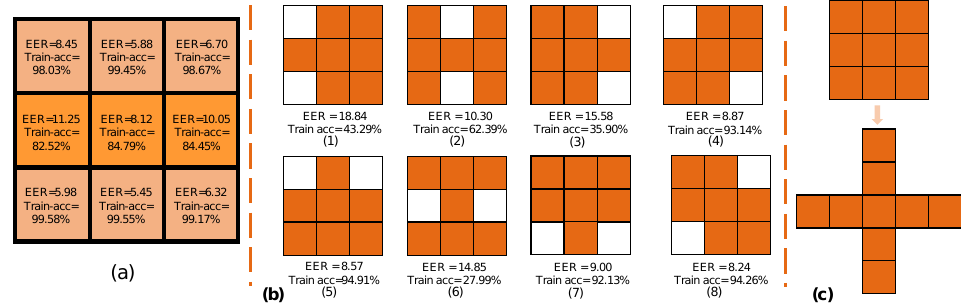
Figure 4. Performance degradation after removing local